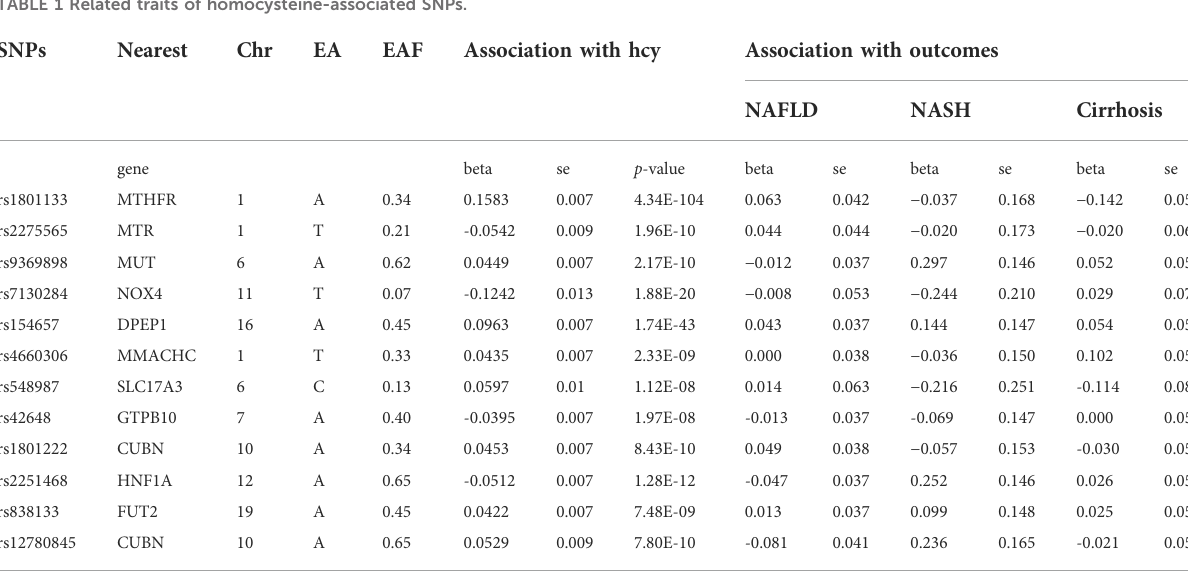
TABLE 1 Related traits of homocysteine-associated